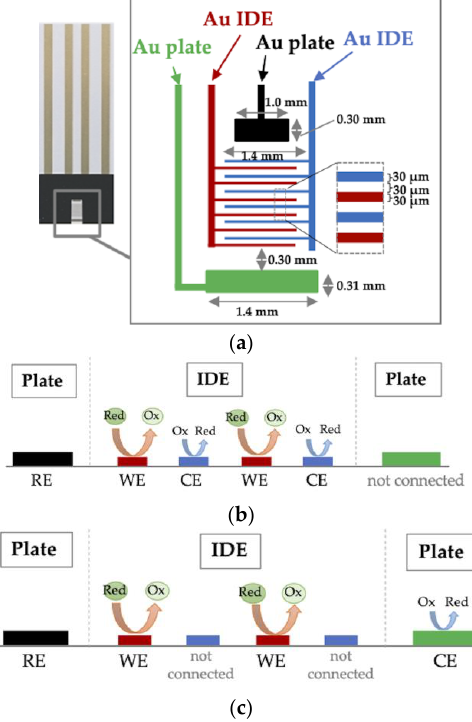
Figure 1. Configuration of the 4-electrode interdigitated electrodes (IDE) strip with the interdigitated array microelectrodes in the middle (red and blue), and two plate electrodes are at the top (black) and bottom (green) ( a ). Scheme of electrode assignments of IDE working electrode (WE) - IDE counter electrode (CE) mode ( b ) and IDE WE-plate CE mode ( c ).